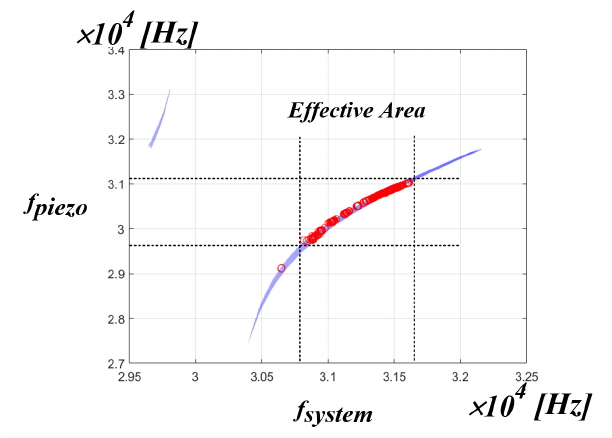
Figure 21. f piezo distribution area.